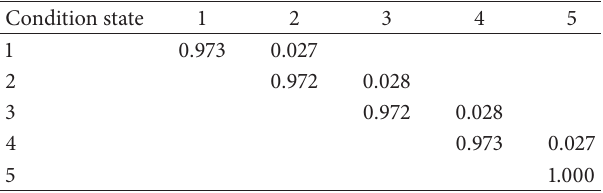
Table 3: Transition probabilities.